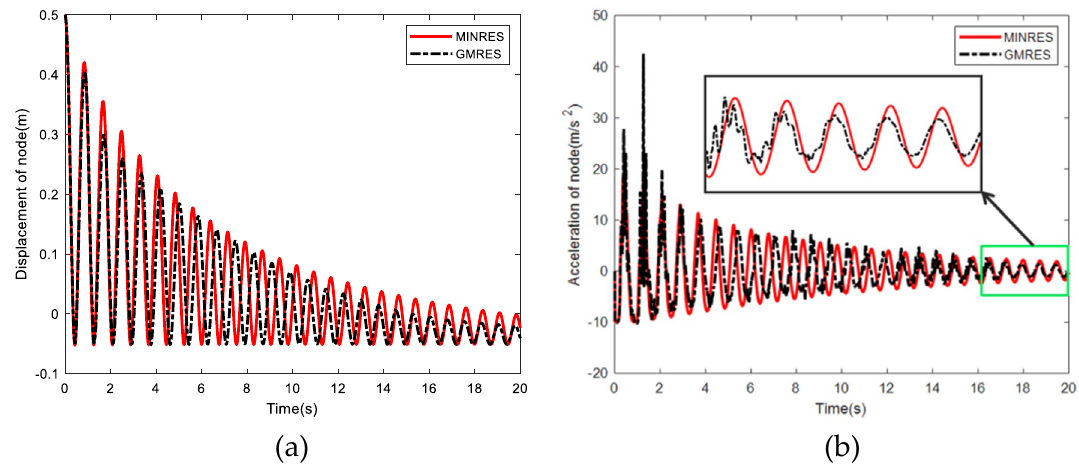
Figure 5. Comparison between GMRES and MINRES. ( a ) Displacement of the beam end node in the Y direction. ( b ) Acceleration of the beam end node in the Y direction.